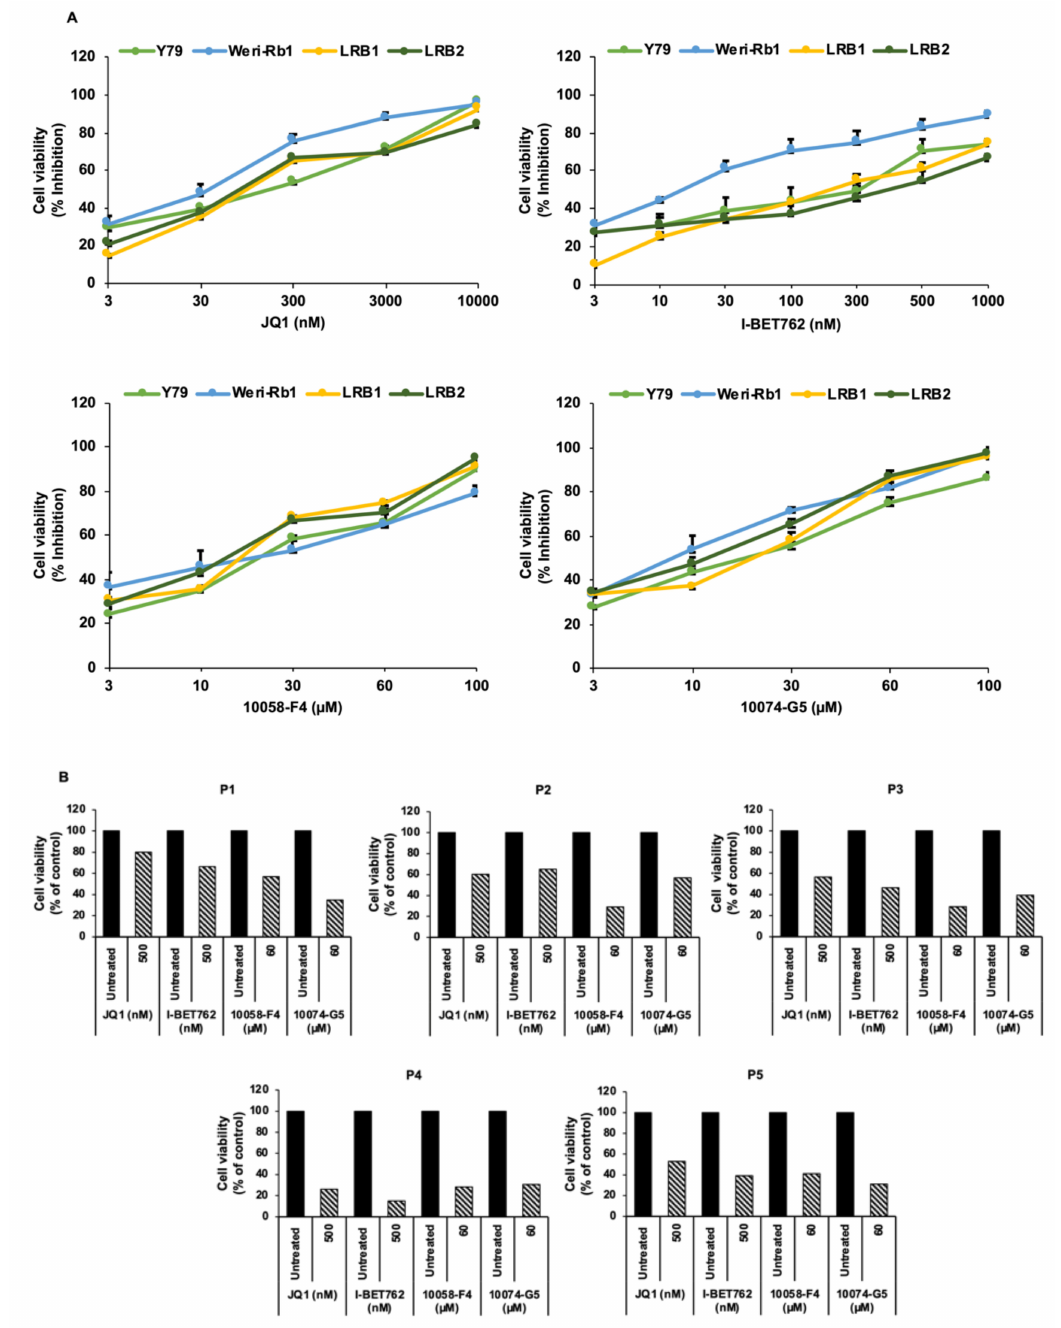
Figure 2. Pharmacological inhibition of MYCN using small molecule inhibitors. ( A ) Cell viability of RB cell lines; Y79 and Weri-Rb1 and patient derived cells; LRB1 and LRB2 upon treatment with small molecule inhibitors. The error bars represent standard error of mean (SEM). ( B ) Cell viability of primary tumor cells (P1-P5) after treatment with MYCN